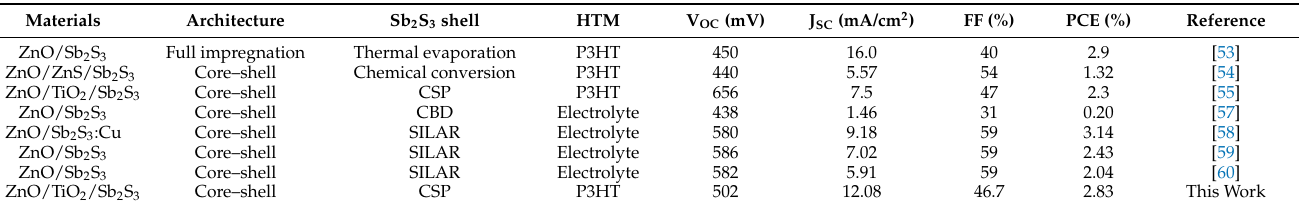
Table 2. Recapitulated photovoltaic properties of the nanostructured solar cells involving the het- erostructures made of ZnO NWs and Sb 2 S 3 in the fully impregnated or core–shell configurations according to the definition used in Reference